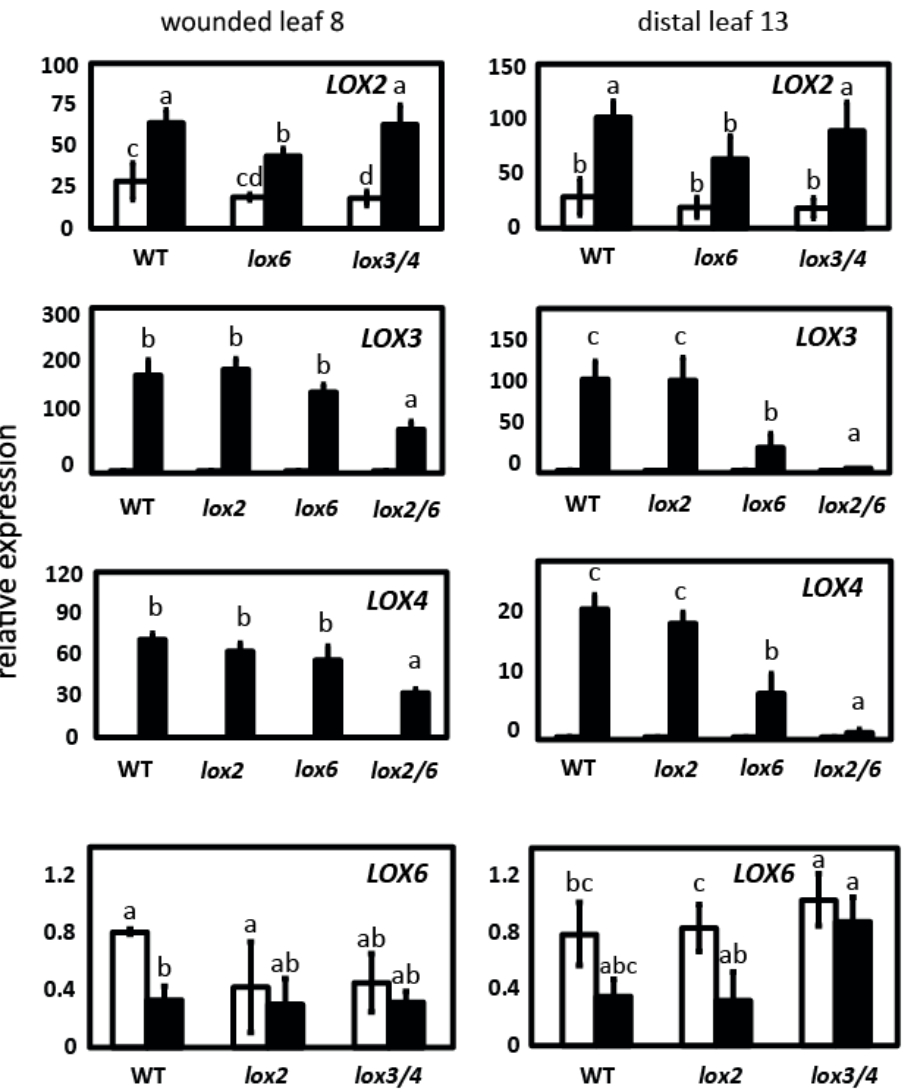
Figure 2. 13-LOX gene expression in different 13-lox mutant backgrounds. LOX2 expression analysed in WT, in lox6A and in lox3B lox4A double mutants. LOX3 and LOX4 expression was analyzed in WT, lox2-1, and lox6A single mutants, and the lox2-1 lox6A double mutant. LOX6 expression was analyzed in lox2-1 and the lox3B lox4A double mutant. Leaves 8 (wounded) and 13 (distal) were snap-frozen before (unfilled bars) and 1 h after the wounding (filled bars). Data are from three (controls) and three to four (wounded) biological replicates (±SD). Letters (a, b, and c) refer to significant differences (ANOVA and t-test; p < 0.05).